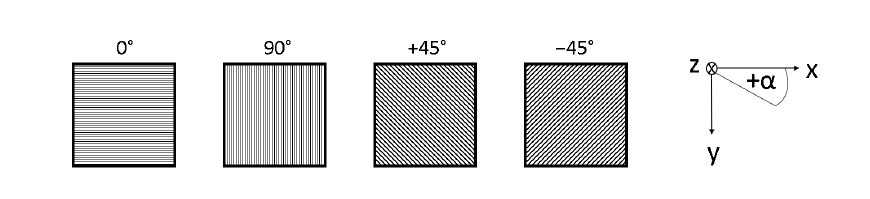
Figure 6. Schematic representation of the prepreg layers inside CFRP test plates. Fiber orientations represented by black lines.